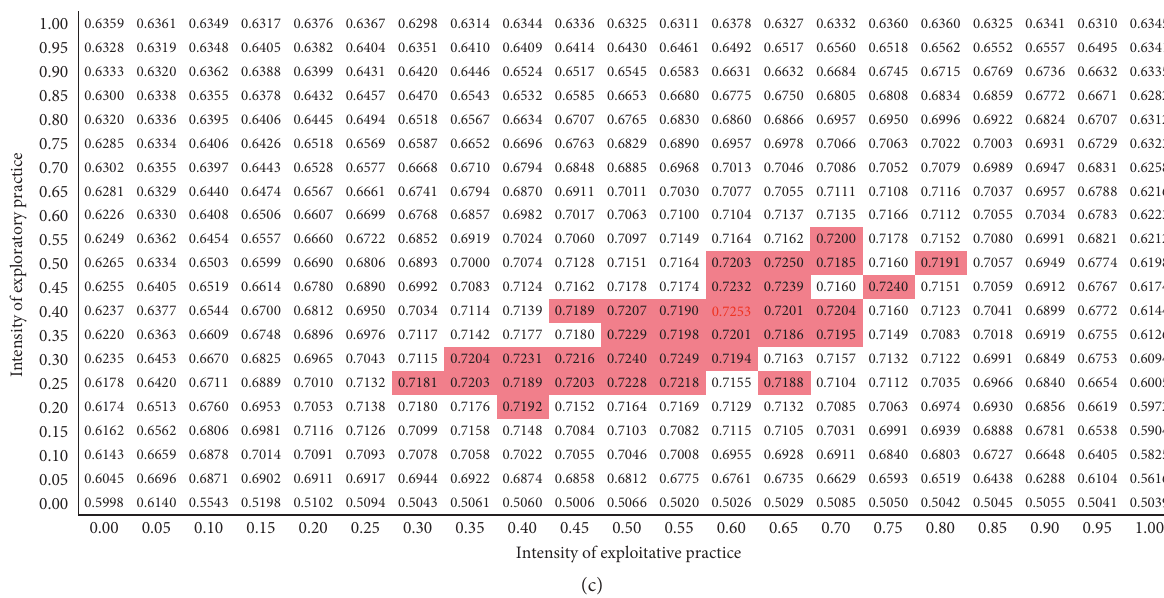
Figure 4: Effect of environmental dynamism on organizational adaptability and practice strategy. (a) p